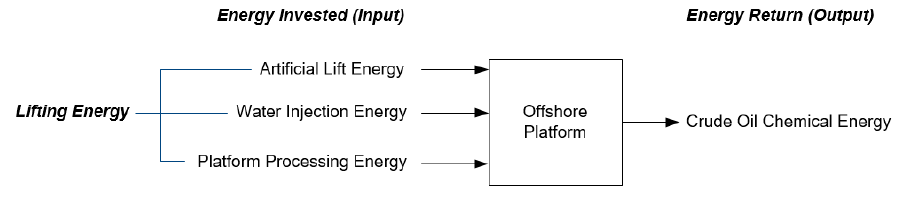
Figure 1. Overall lifting energy balance.